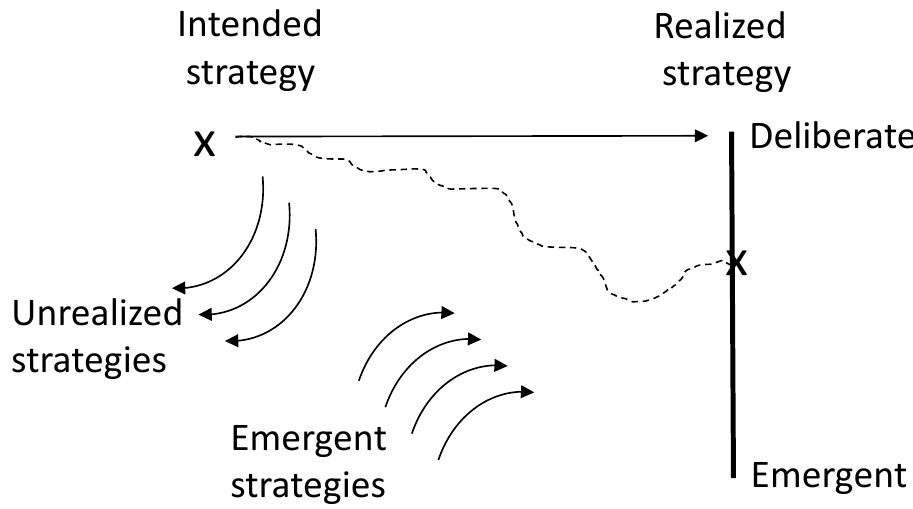
Figure 2. Intended and realized strategies, after Mintzberg and Waters